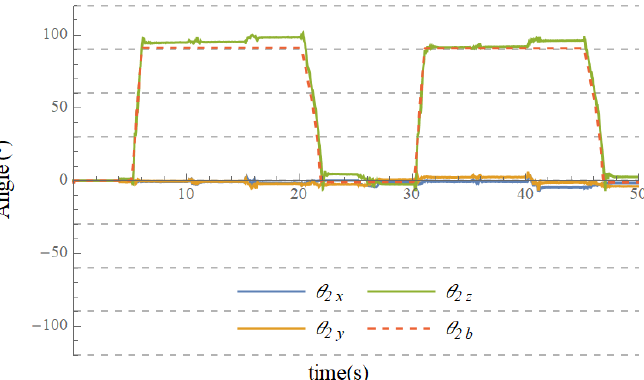
Figure 14. Evolution of Rotation Vector 2 when testing the link model using all measurements.